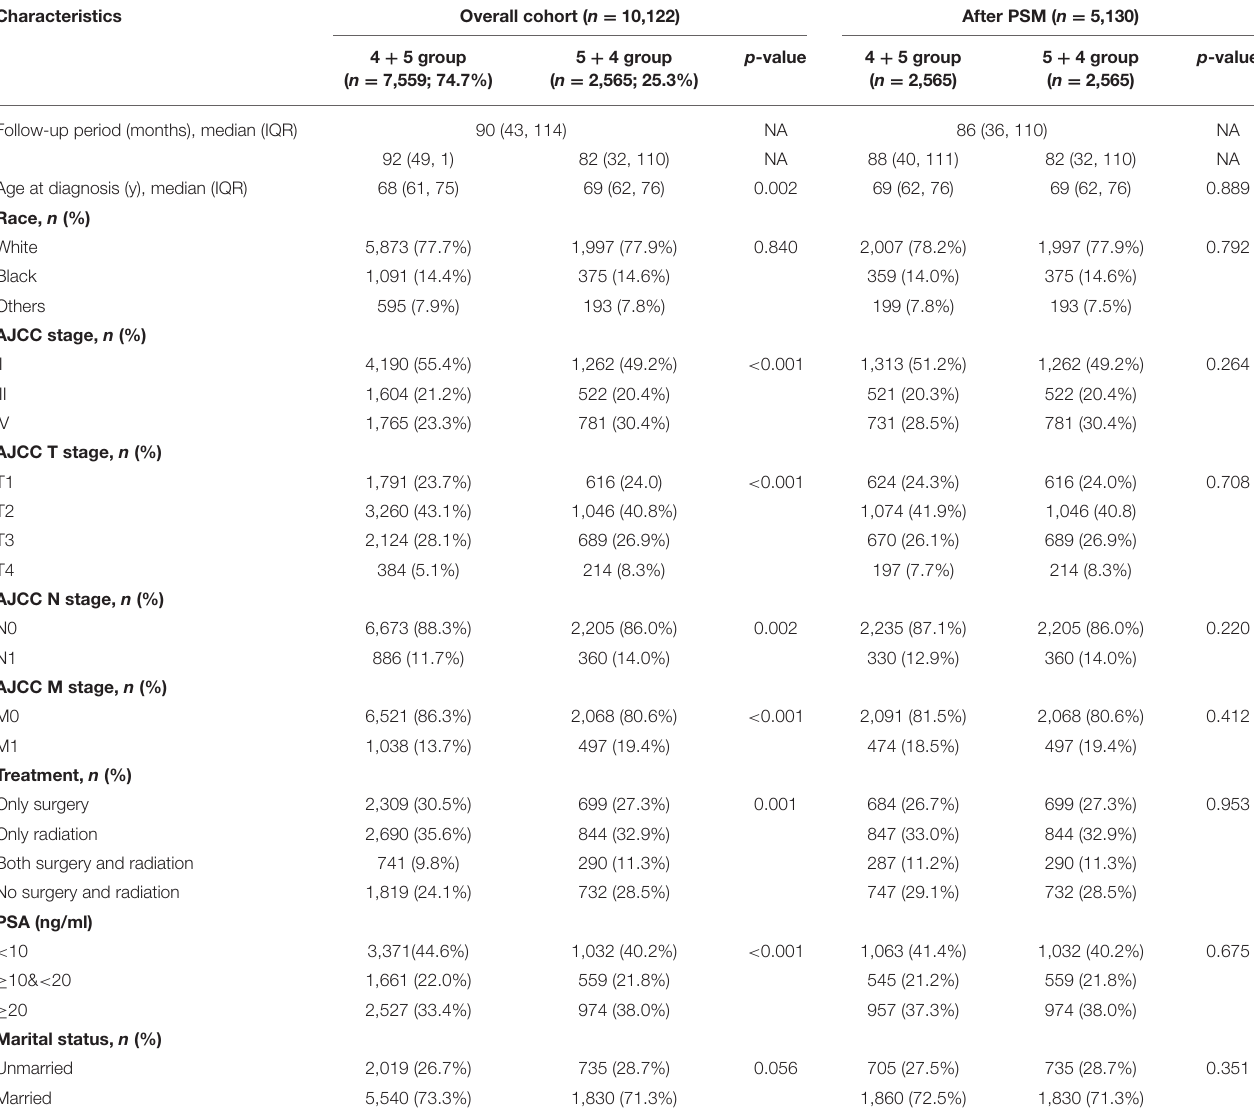
TABLE 1 | Baseline characteristics of patients between the GP 4 + 5 and 5 + 4 groups before ( n = 10,124) and after PSM ( n = 5,130).